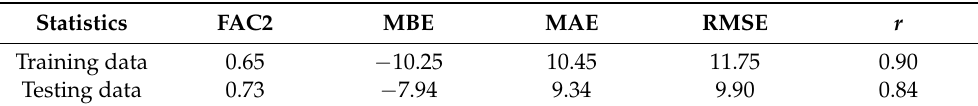
Table 8. Statistical metrics assessing the model performance by comparing observed and predicted concentrations for both the training and testing datasets, using NO and O 3 as exogenous variables. MBE, MAE and RMSE are expressed in µ g/m 3